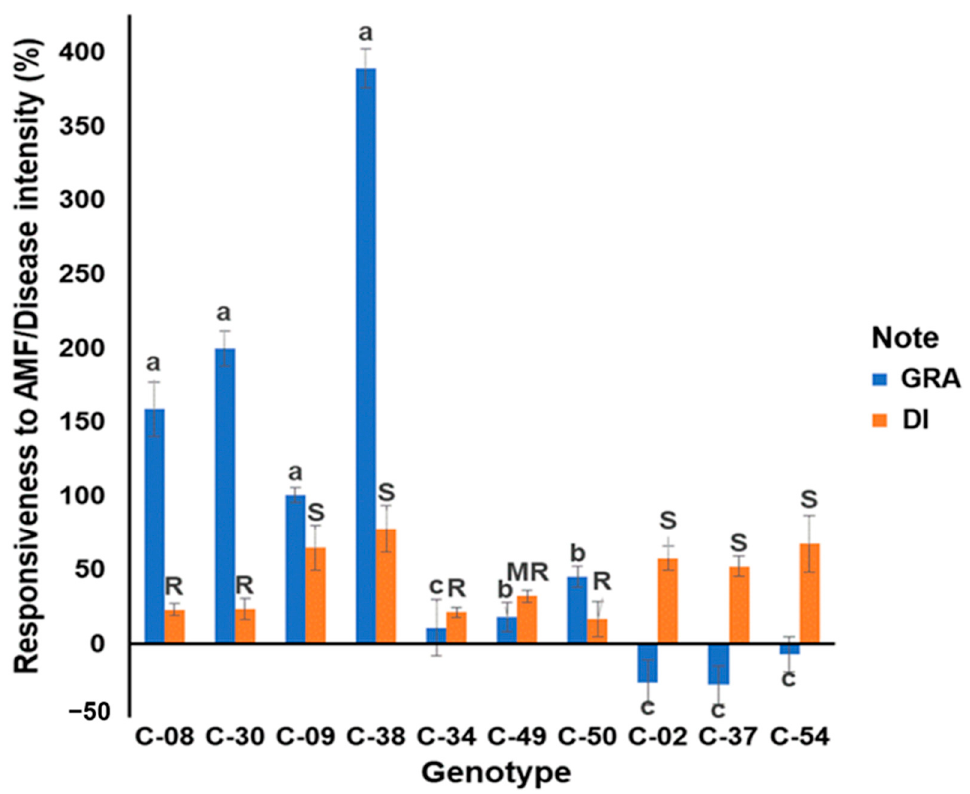
Figure 1. The growth responsiveness of the tropical chili pepper genotypes to mycorrhizae (GRA) and the disease intensity of the tropical chili pepper genotypes to R. solanacearum (DI) at 35 days after inoculation (DAI). Note: The same lowercase letters in the GRA histogram indicate no significant differences between the genotypes at a significance level of 0.95 according to the Scott-Knott test. The uppercase letters in the DI histogram indicate the resistance of the genotypes based on the disease intensity at 35 DAI. Bars represent the mean ± standard deviation. AMF: arbuscular mycorrhizal fungi. GRA: the growth response of genotype to mycorrhiza; DI: disease intensity at 35 DAI. R: resistant; MR: moderately resistant; and S: susceptible; C-50: resistant check cultivar and C-54: susceptible check cultivar to R. solanacearum according to their published cultivar’s description.